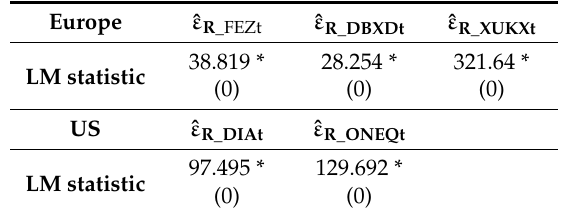
Table 7. ARCH-LM Tests for European and US Market ETF Returns. Europe ˆ ε R _FEZt